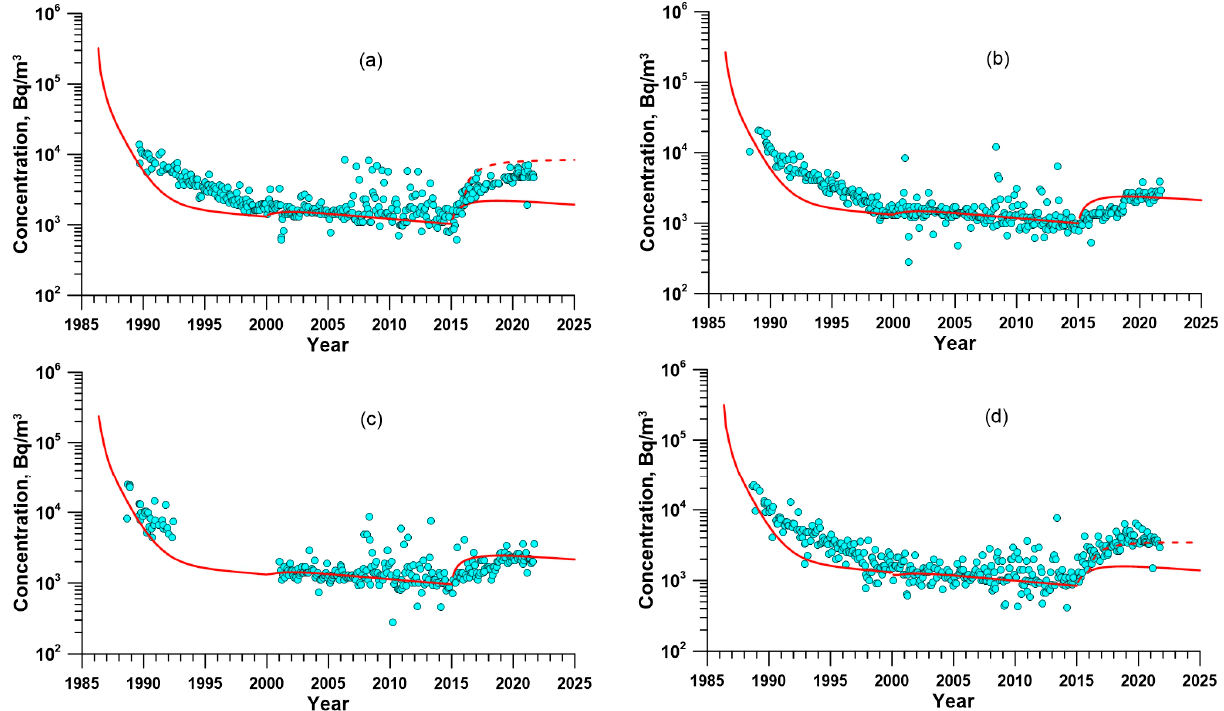
Figure 7. Calculated (line) and measured (dots) concentrations of 90 Sr in the water of the CP: ( a ) Sector 1; ( b ) Sector 4; ( c ) Sector 5; ( d ) Sector 8. Dashed line corresponds to the scenario with an additional source of 90 Sr equal to 3 GBq/y after the water level drawdown.